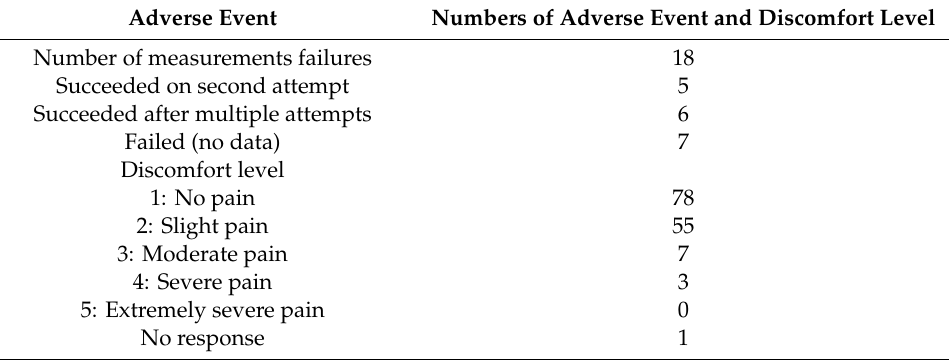
Table 3. Measurement failures and discomfort level of I-Pen